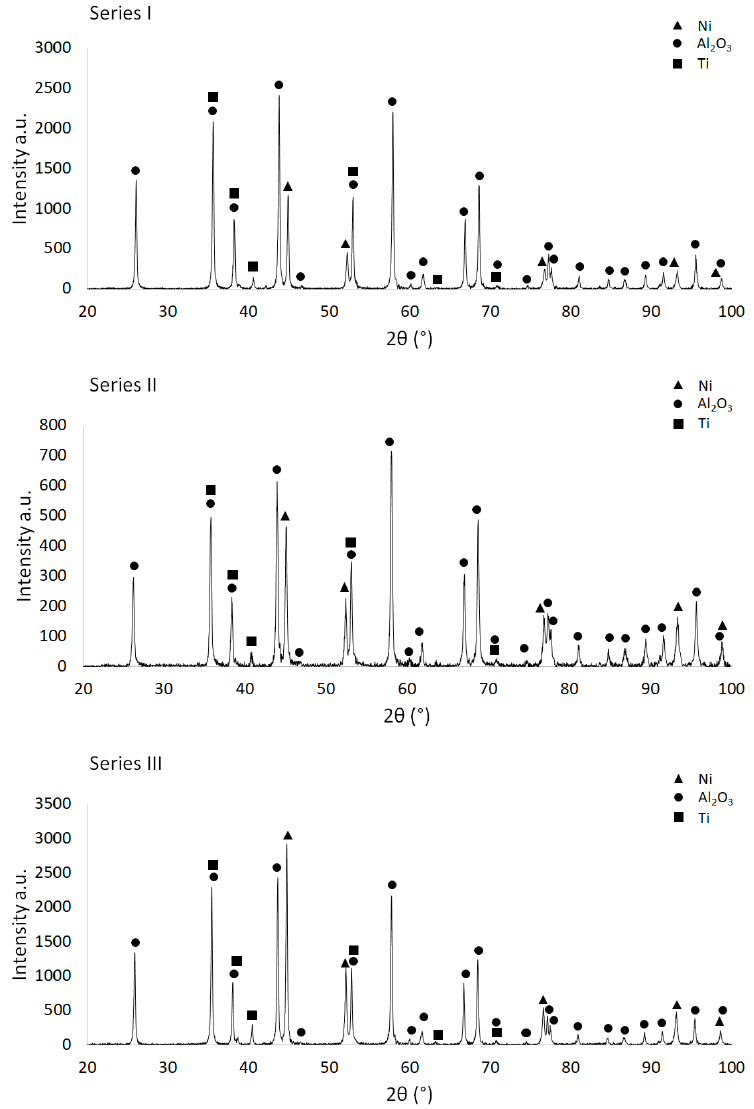
Figure 7. Diffractograms for raw samples.